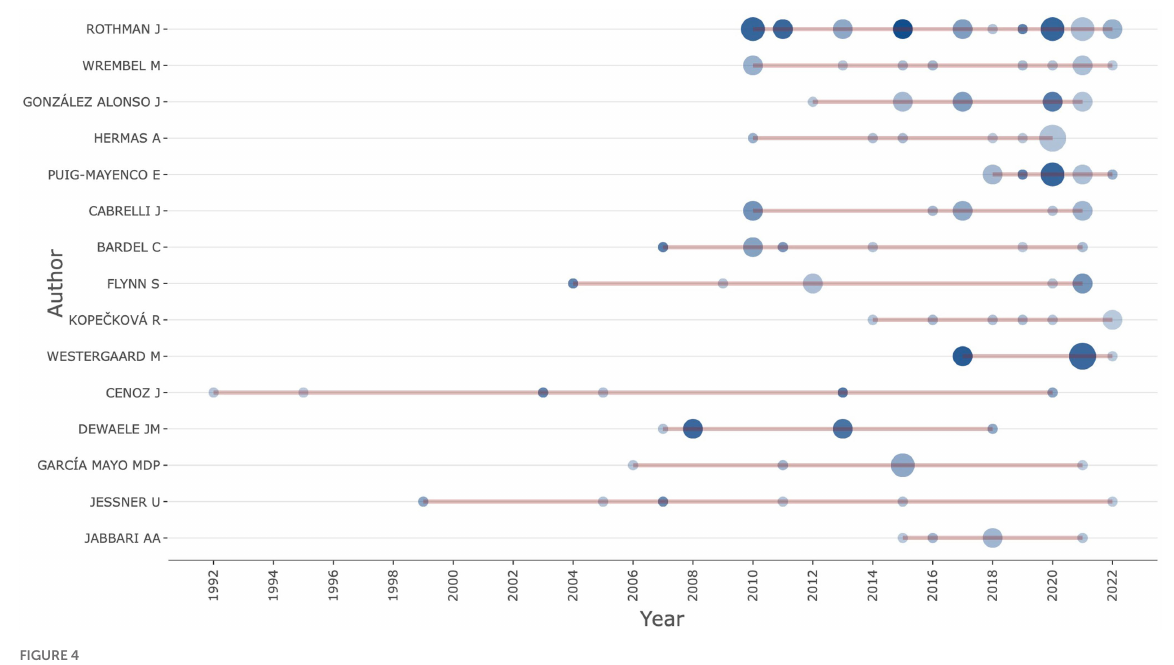
FIGURE 4 Authors’ Production over Time (top 15).